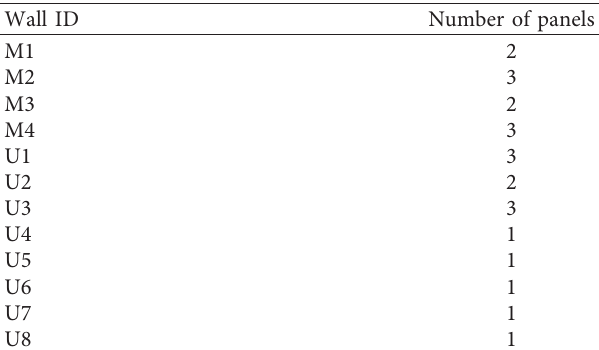
Table 2: Wall panelization